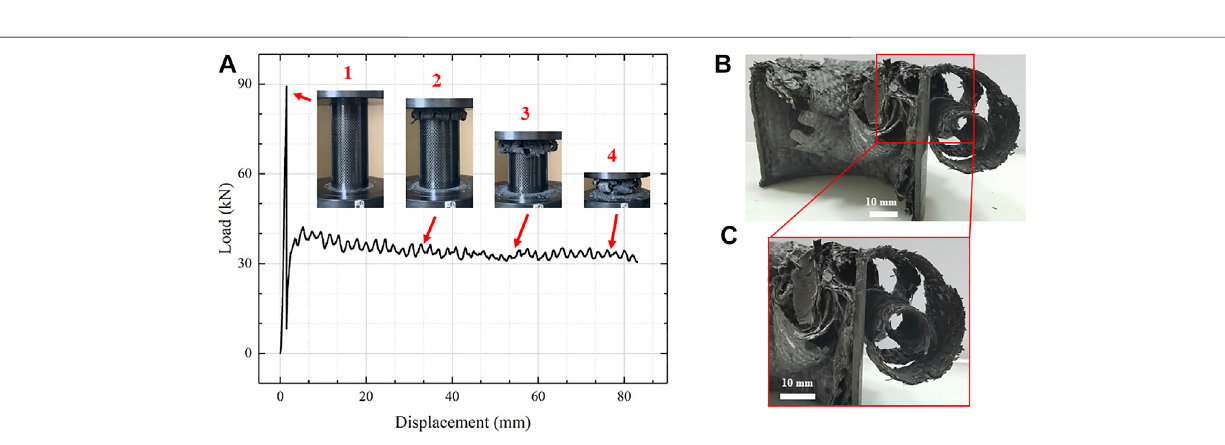
Frontiers in Materials |